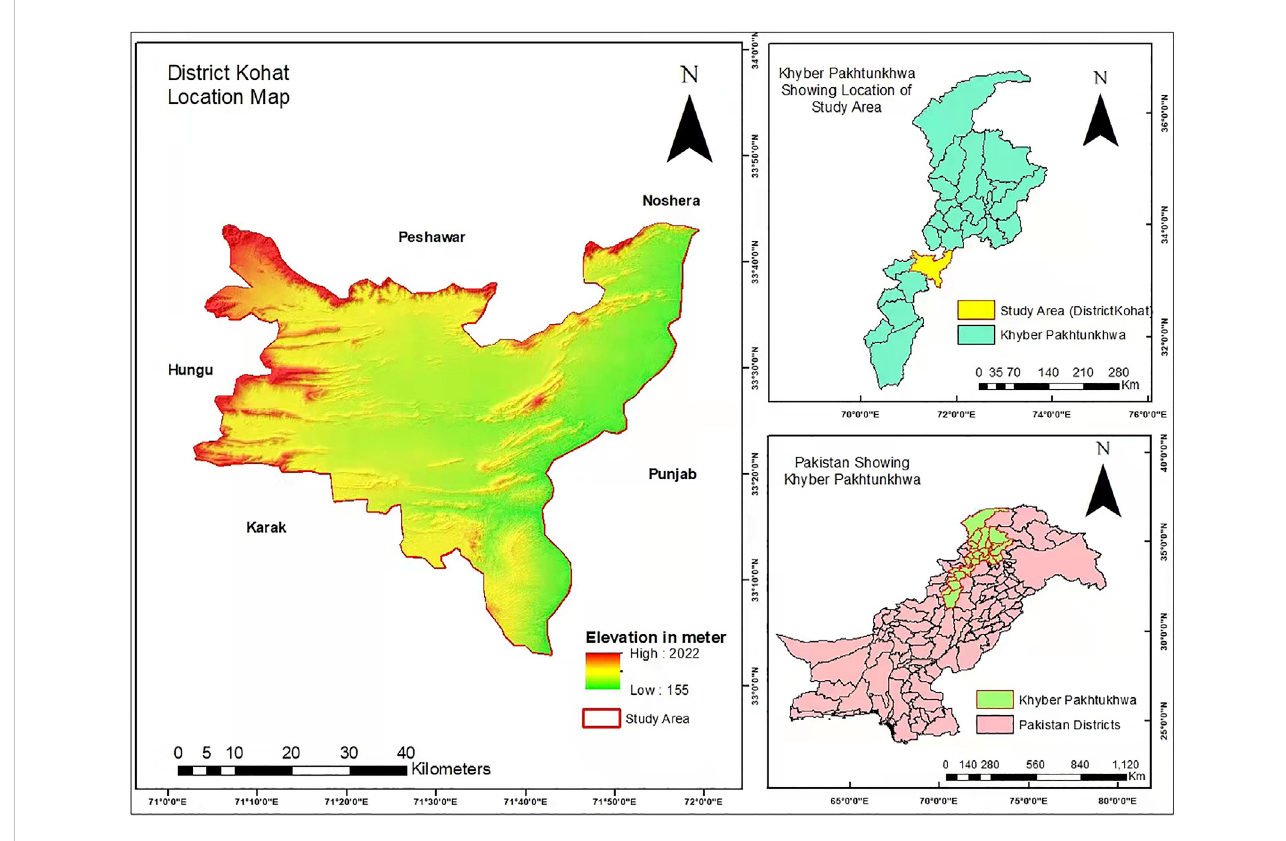
FIGURE 1 Kohat District area